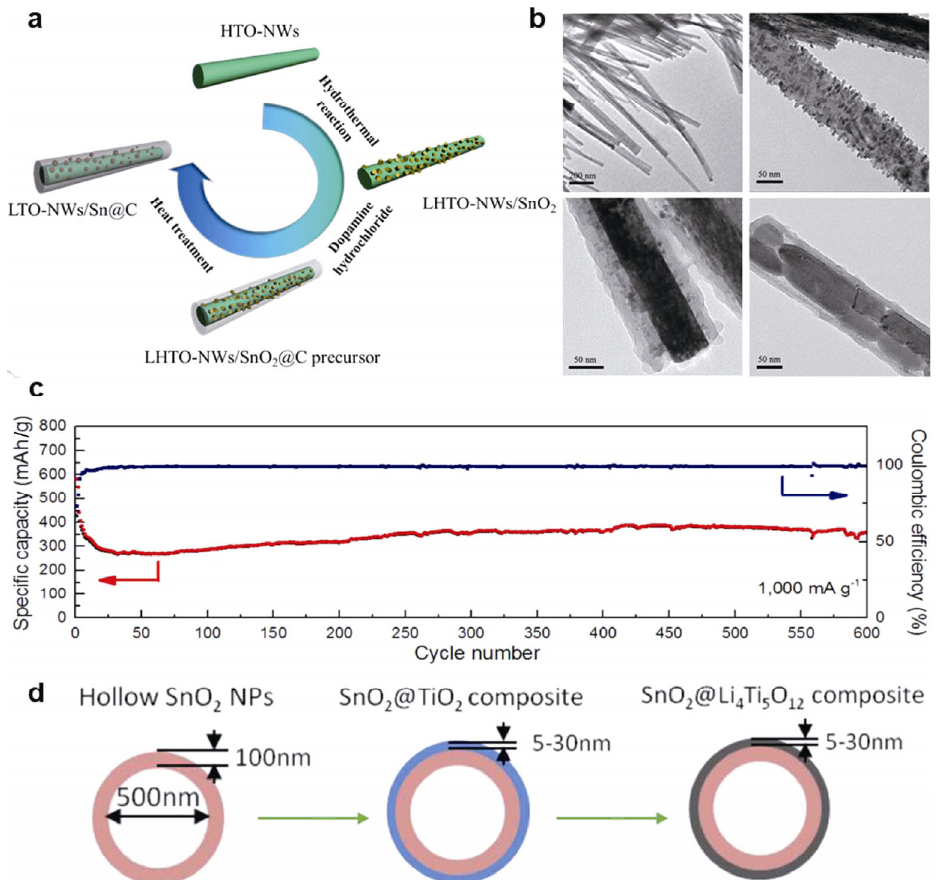
Fig. 8 Recent progress of Li 4 Ti 5 O 12 hybrid nanocomposites with alloying-type anodes. (a) Schematic illustration, (b) TEM images of the fabrication process of Li 4 Ti 5 O 12 –TiO 2 /Sn nanowires, and (c) cycling performances of Li 4 Ti 5 O 12 –TiO 2 /Sn composite. Reproduced with permission from Ref. [82], © The Royal Society of Chemistry 2016. (d) Schematic illustration of